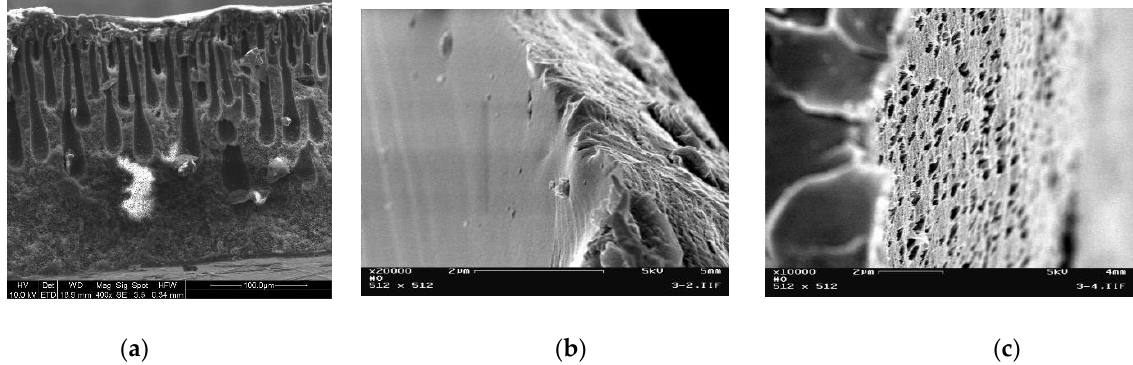
Figure 6. HRSEM images of the cross-section of the membranes produced by Method B using bis-carboxylated polysulfones: ( a ) before the crosslinking; ( b ) after crosslinking with a diol. The top of the membrane is on the left side ( c ) after 6 h of hydrolysis of some of the ester bonds. The top of the membrane is on the right side.